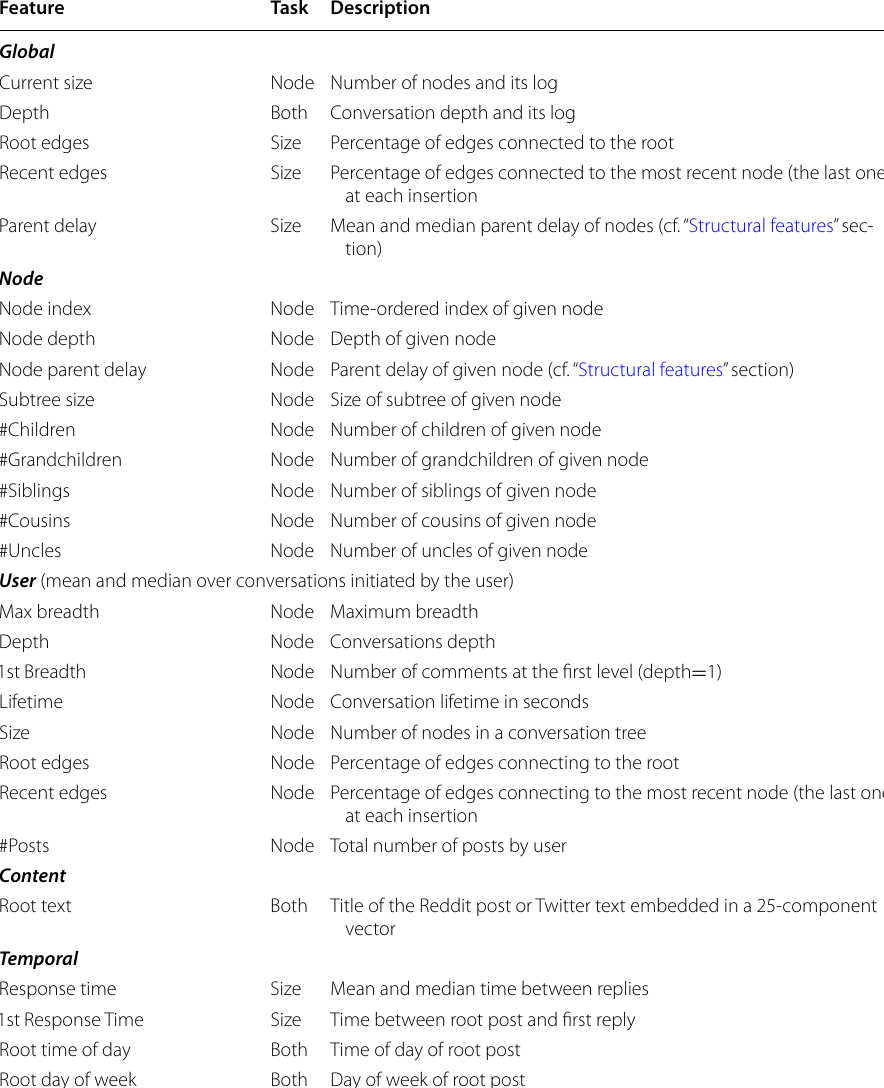
Table 3 Description of features, grouped by class, showing if they were used in the size prediction regression model, the node placement classifier, or